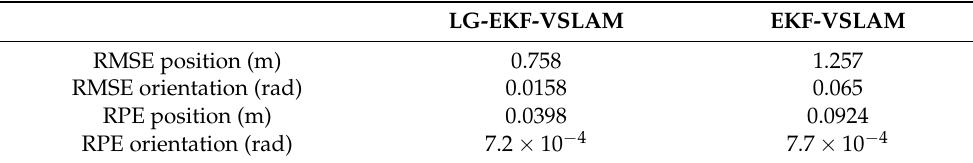
Table 2. Simulation results with misspecified L . Obtained performance estimation for N r = 500 realizations. LG-EKF-VSLAM EKF-VSLAM